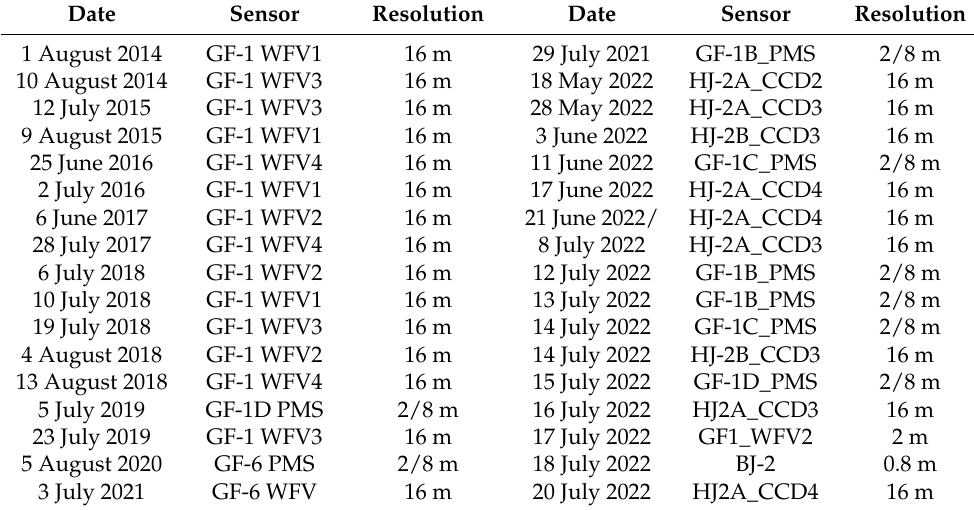
Table 1. Satellite images from 2014 to 2022.